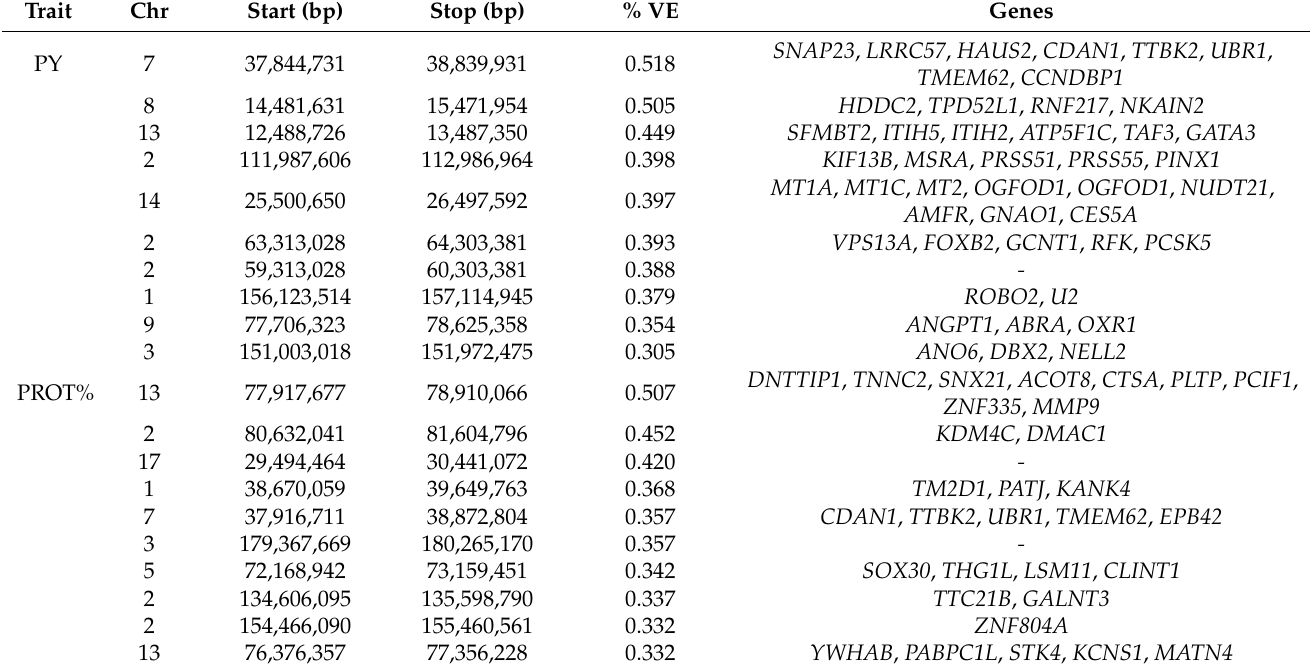
Table 4. Identification of genes based on additive genetic variance explained by top 10 window regions for milk protein yield and protein percentage